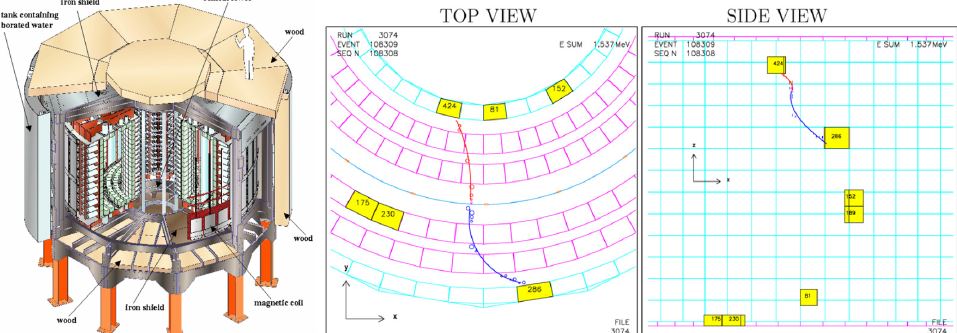
Figure 4. ( left ) Schematic view of the NEMO-3 detector. ( right ) A reconstructed event candidate for 2 β − decay of 100 Mo to the excited 0 + state of 100 Ru. Two electrons of 424 and 286 keV energy, 1 with a common origin in the source foil, hit fired isolated scintillators. The remaining fired scintillators compose three γ clusters, two are due to γ rays emitted in coincidence with the electrons, the third cluster is most probably due to the rescattering of one of these γ rays. Reprinted from Reference [26] with permission from